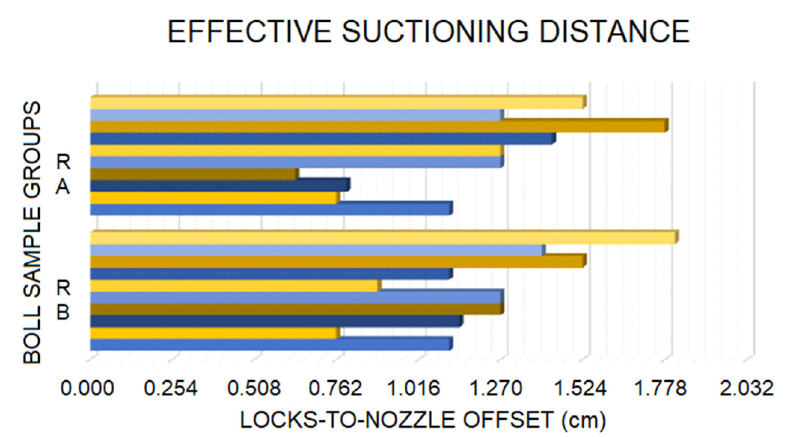
Figure 16. Results of how close the locks/boll should be to the nozzle for suctioning.